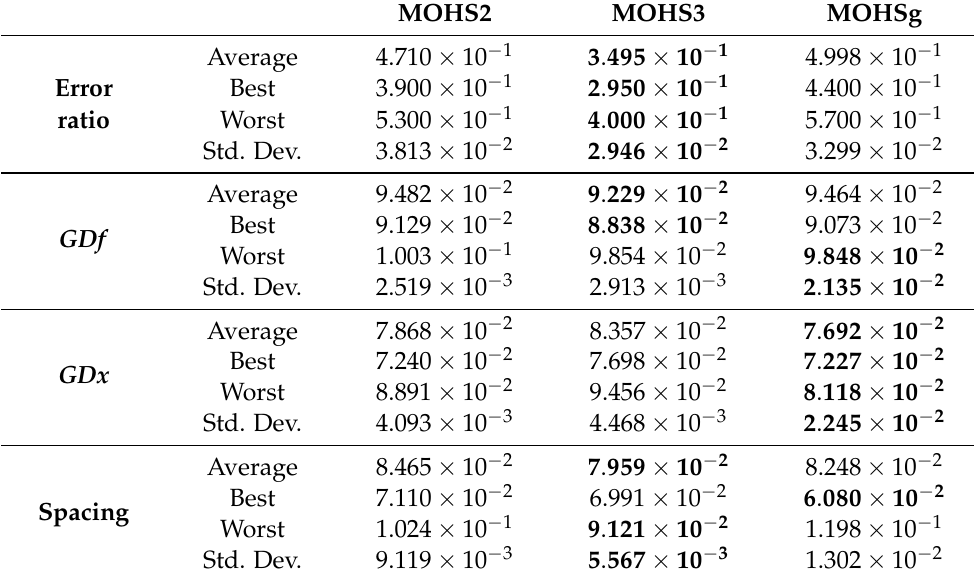
Figure 13. Pareto sets for problem P6. Table 8. Statistic analysis for problem